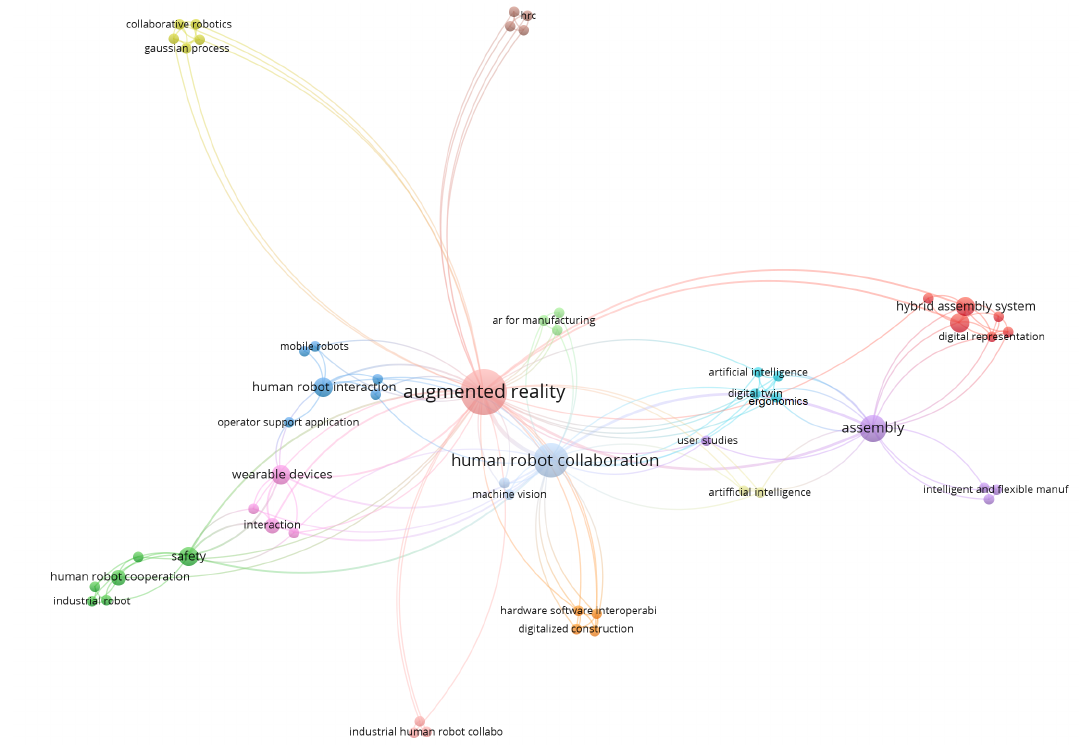
Figure 8. Author keywords’ co-occurrence